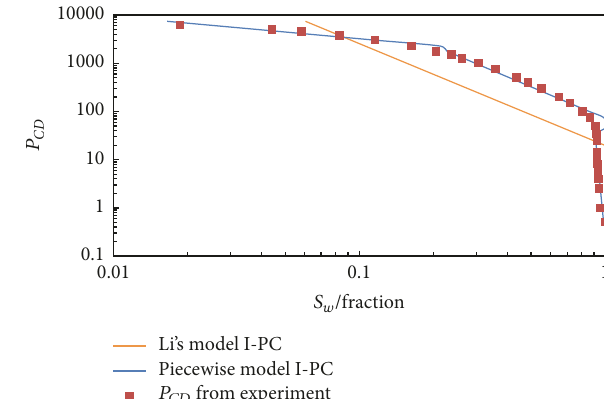
Figure 3: Relationship between 𝑇 2𝑙𝑚 and 𝑟 𝑚 in the study area.